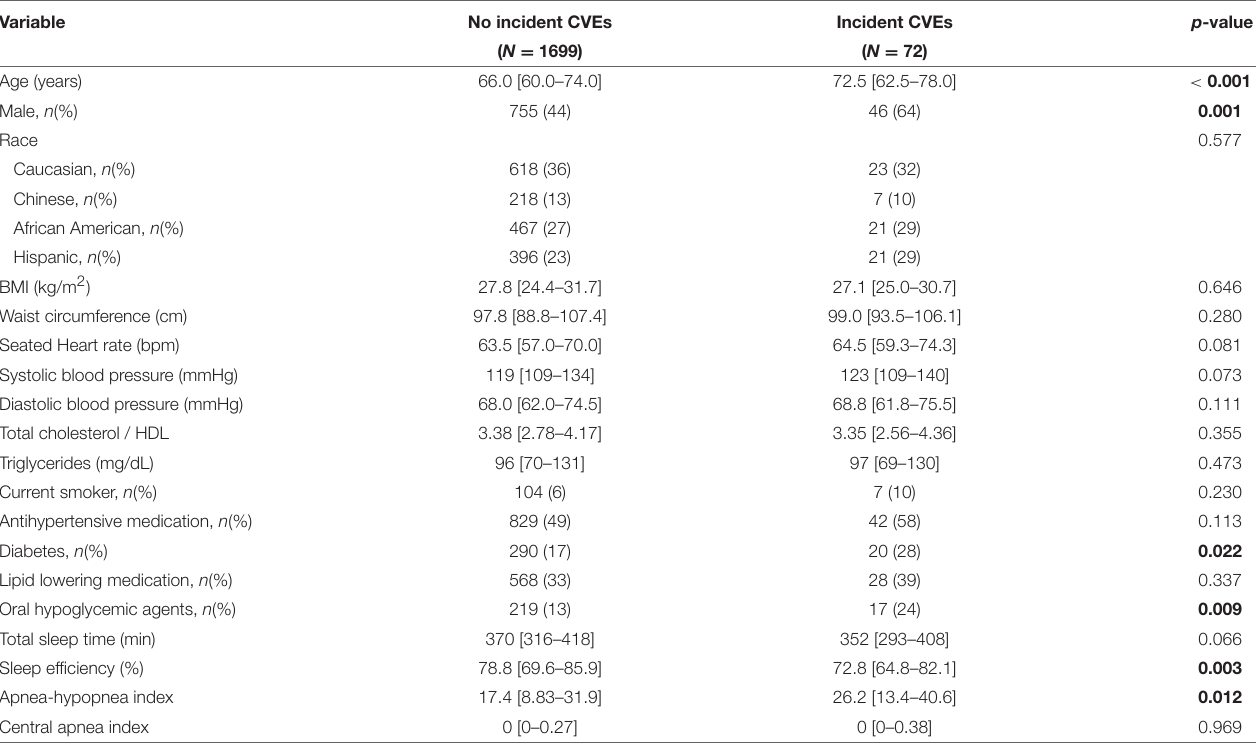
TABLE 1 | Characteristics of MESA participants without and with a CVE during follow-up.